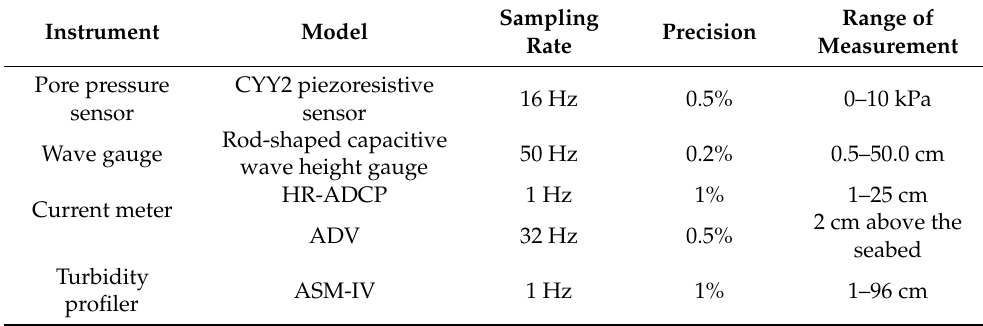
Figure 1. Layout of the experimental flume and particle size distribution curve of the experimental soil.: ( a ) layout of the experimental flume; ( b ) layout of measuring instruments and sensors; ( c ) particle size distribution curve of the experimental soil. Note: d 50 is the average particle size of the soil and CC is the percentage of clayey particles in the soil. Table 1. Parameters of the measuring instruments used in our experiments.